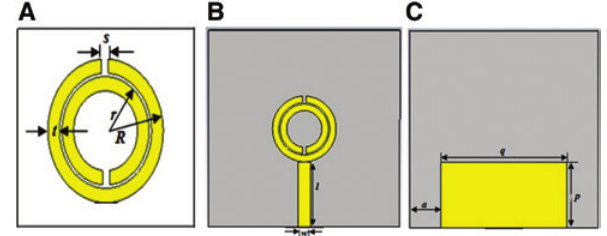
Table 1: Design specifications of the metamaterial